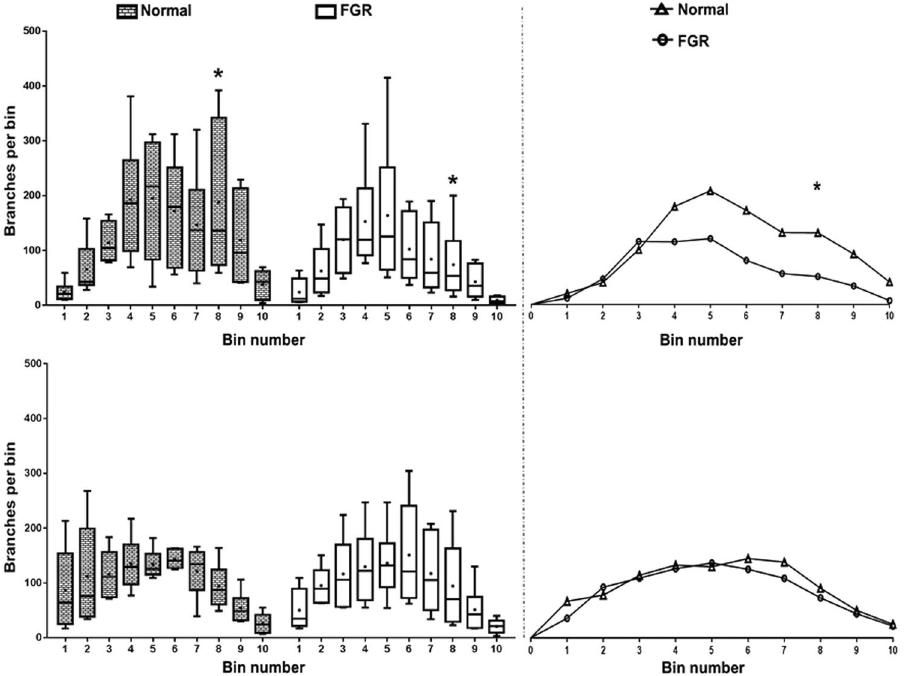
Figure 6. The number of branches in each of the ten bins in the tree maps. Graphs represent arterial (top left) and venous (bottom left) tree maps. Line and dots within the boxes represent the median and mean respectively. There are significantly fewer branches in the FGR arterial trees around the level of the 8 th bin of branches compared to normal while there is no difference in the number of branches in the venous trees. Curves on the top and bottom right represent the relationship between the median number of branches in the arterial and venous trees respectively. There is a trend suggesting fewer number of branches in the 4 th –10 th bins of branches in the FGR arterial trees (top right). This trend is absent in the venous trees (bottom right). Data presented as boxplots showing the median, range and interquartile range. n = 12 normal (6 arterial, 6 venous) and 12 FGR (6 arterial, 6 venous) casts. Two-way RM Anova with Sidak’s multiple comparison test, alpha value = 0.05, * marks two-tailed p value =